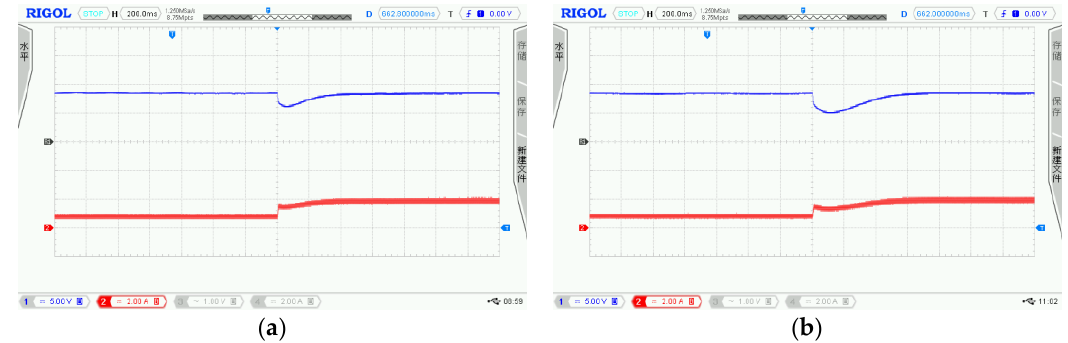
Figure 16. ( a ) LADRC controller: experimental comparison responses with Case 2; and ( b ) PI controller: experimental comparison responses with case 2.